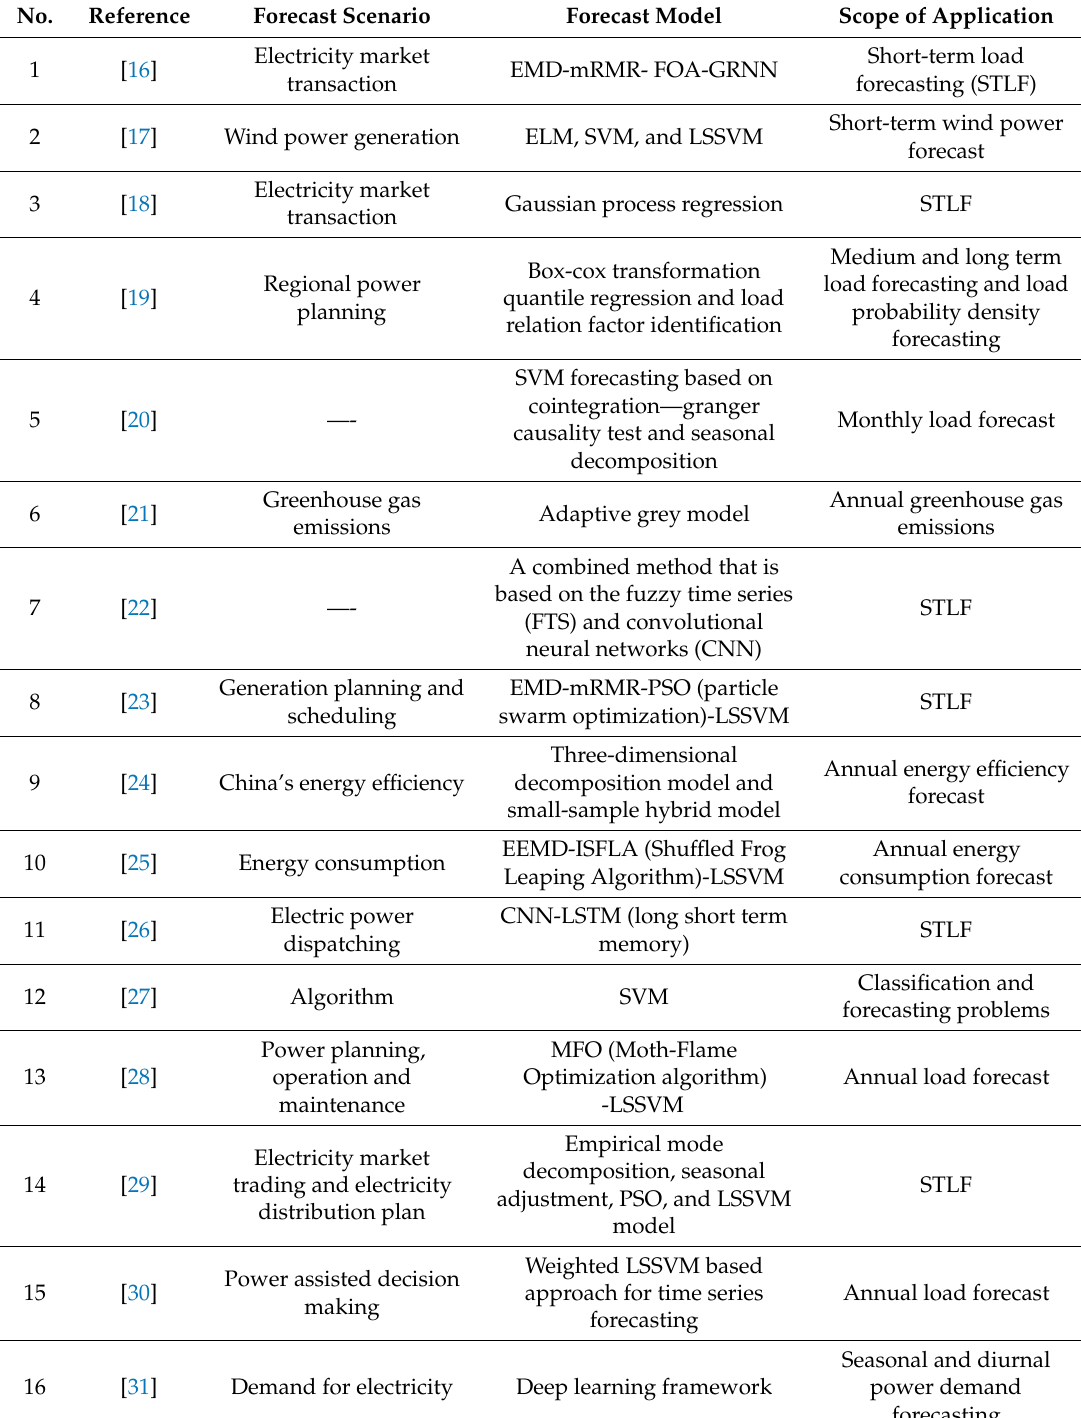
Table 1. Introduction of partial load forecasting